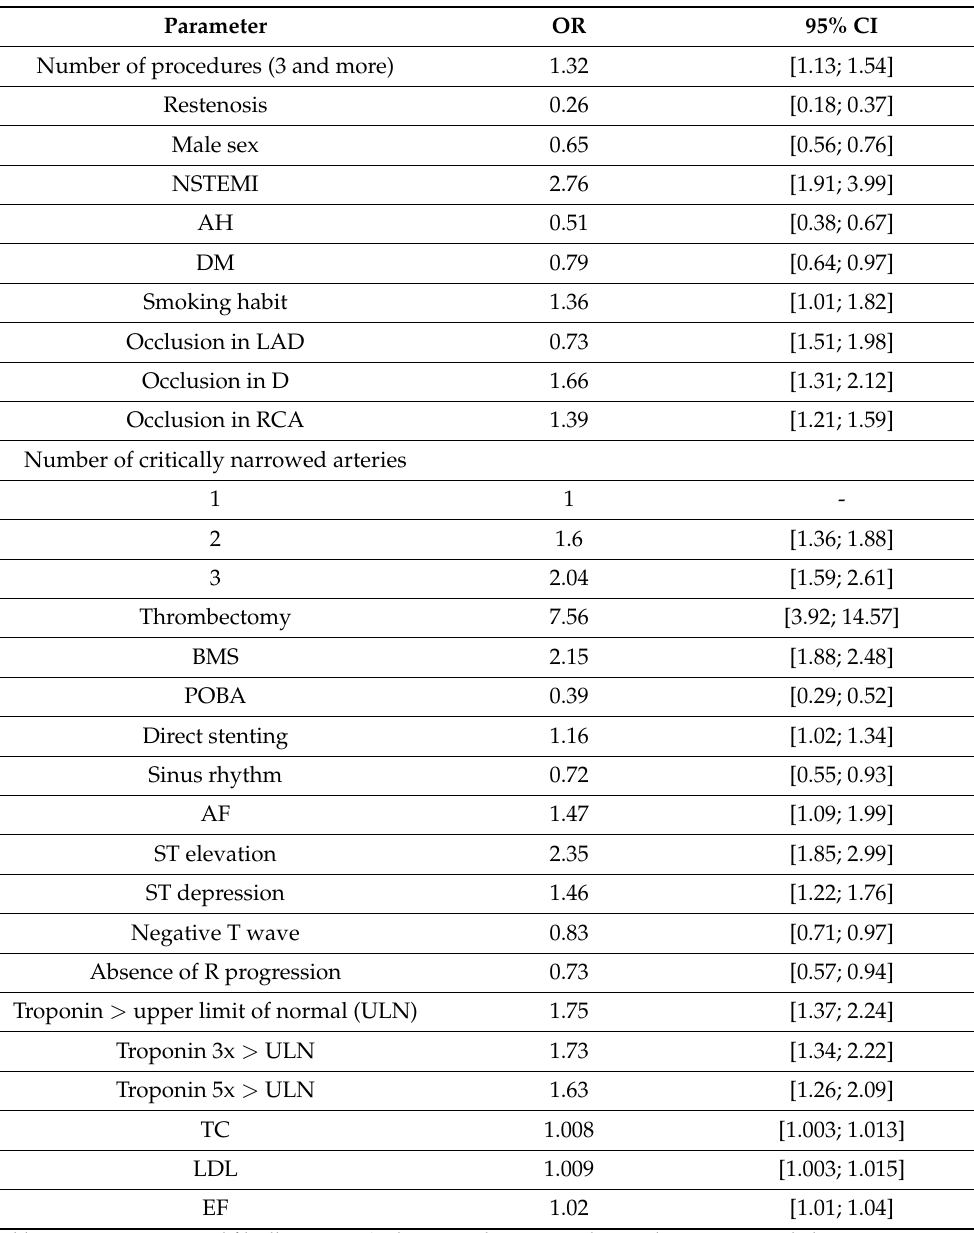
Table 4. Results of one-dimensional logistic regression for subgroups A vs. B + C (B + C as a